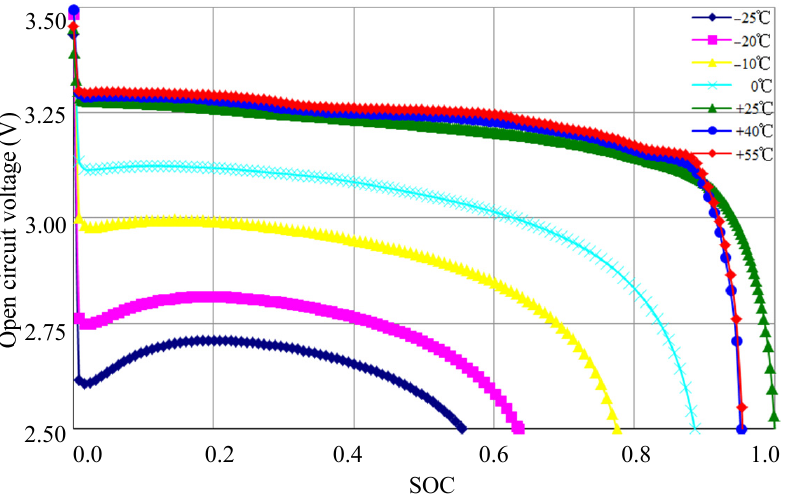
Figure 2. Characteristics curves on OCV and SOC.